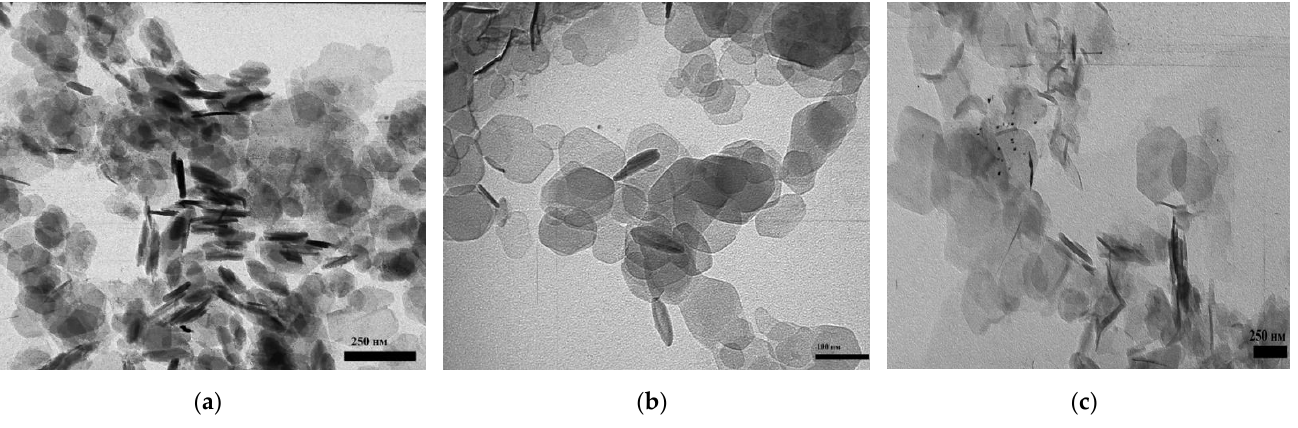
Figure 4. TEM micrographs of: ( a ) Mg/AlNi 25-c, ( b ) Mg/AlNi 25-ht, ( c ) Mg/AlNi 25-mw.